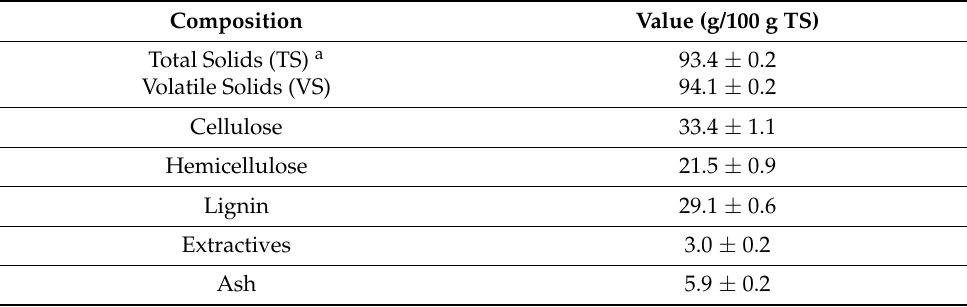
Table 1. The main characteristics of WS used in the